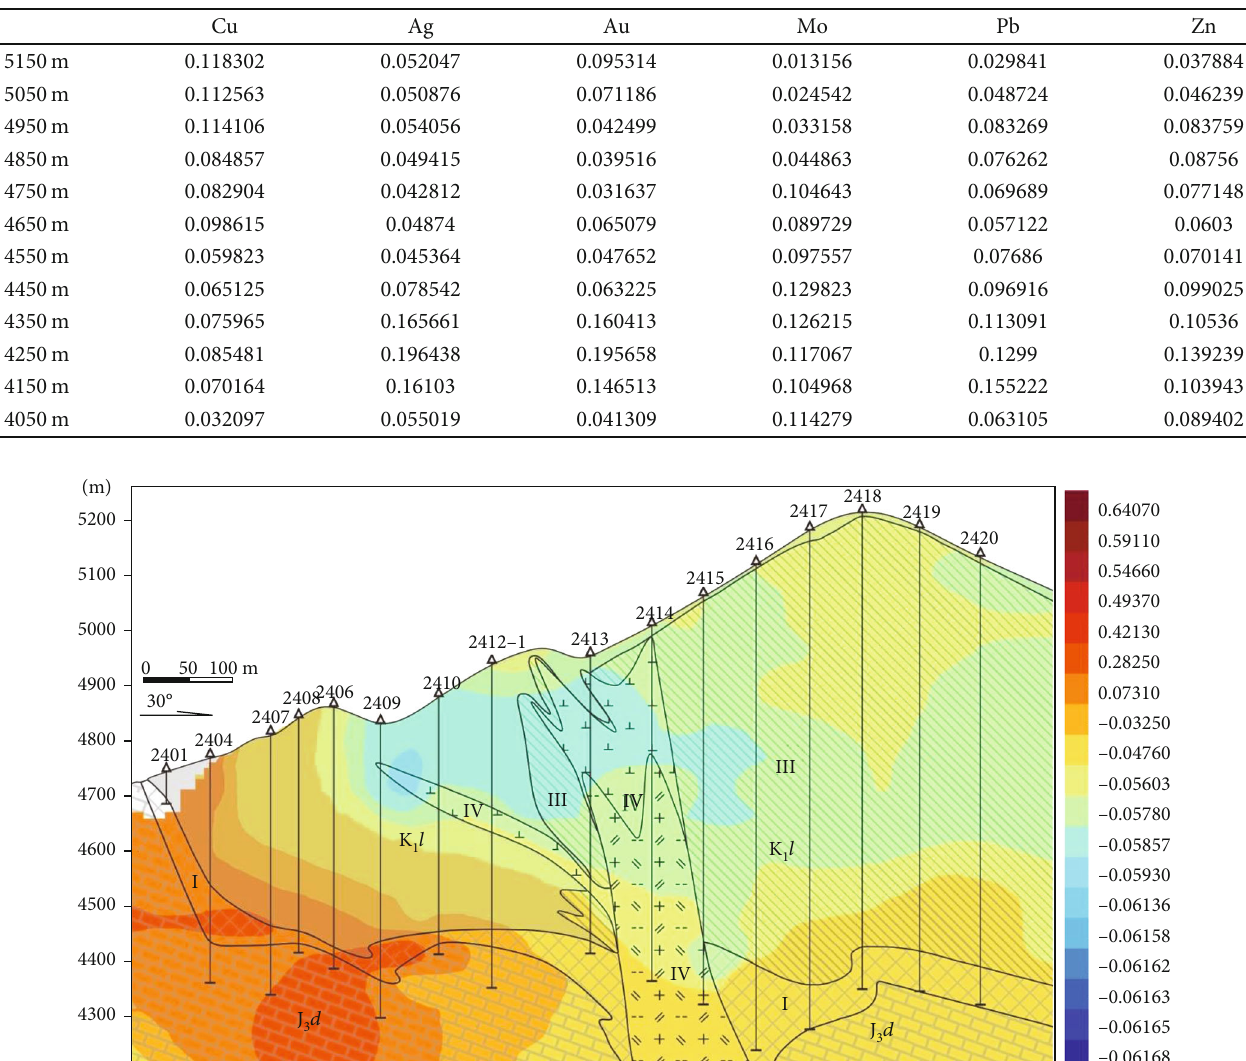
Table 3: Normalized linear metal productivities at di ff erent elevations.